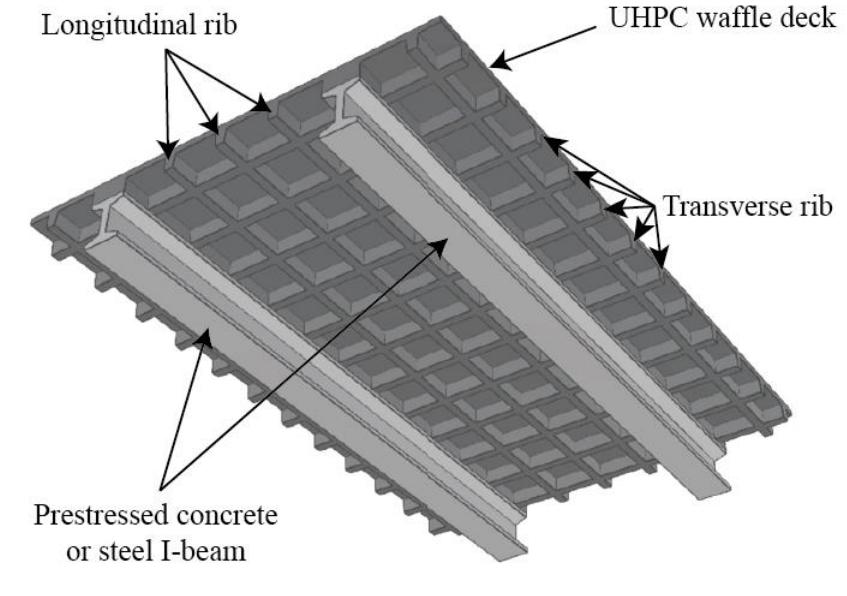
Figure 1. Schematic illustration of UHPC waffle bridge deck.